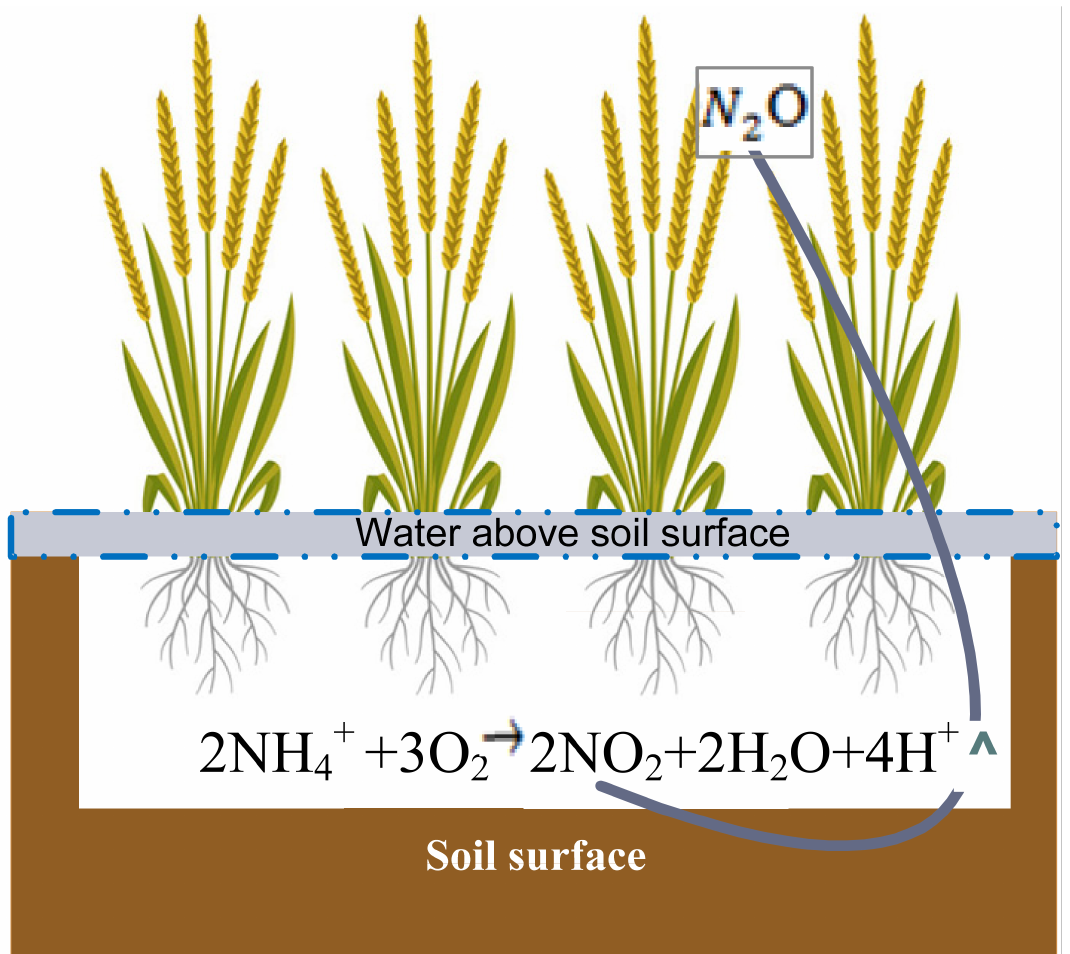
Figure 1. The process of N 2 O production and emission from rice